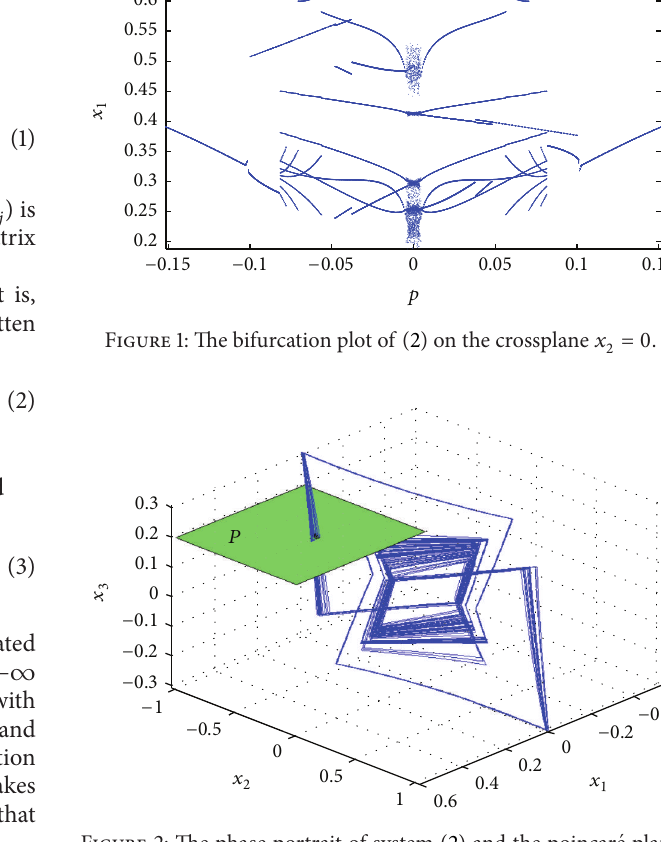
Figure 2: The phase portrait of system (2) and the poincar´e plane = 0.2 . 𝑃 : 𝑥 3 Table 1: Equilibrium points of (2) as we adjust 𝑝 from −∞ to +∞